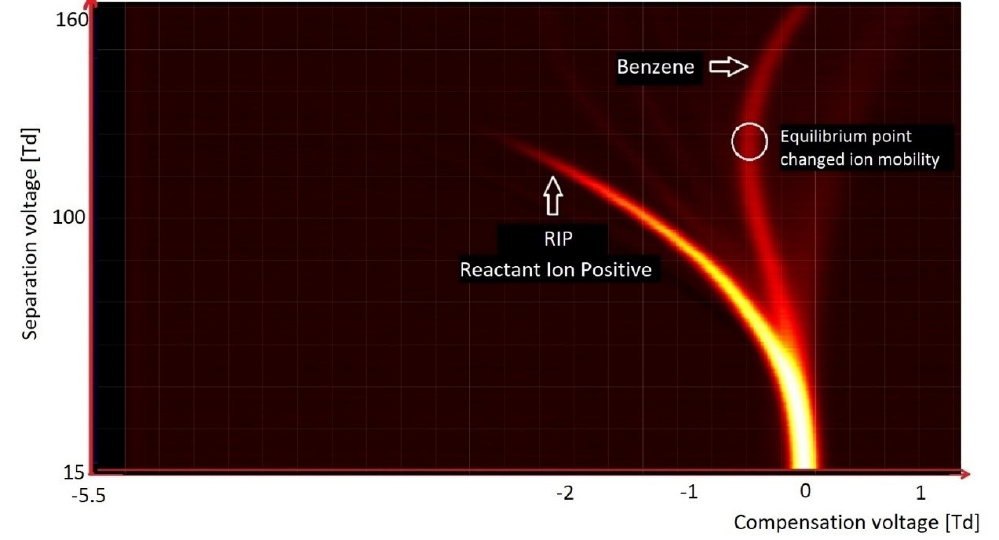
Figure 11. DMS spectrogram of benzene.